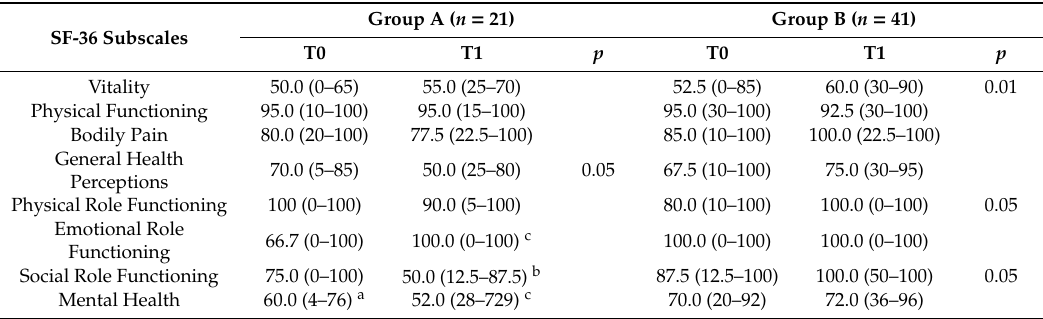
Table 4. Median scores and ranges of SF-36 subscales in CHC patients with (Group A) and without (Group B) a current or lifetime psychiatric history, before (T0) and 12 weeks after completing treatment with direct-acting antiviral (DAA) agents